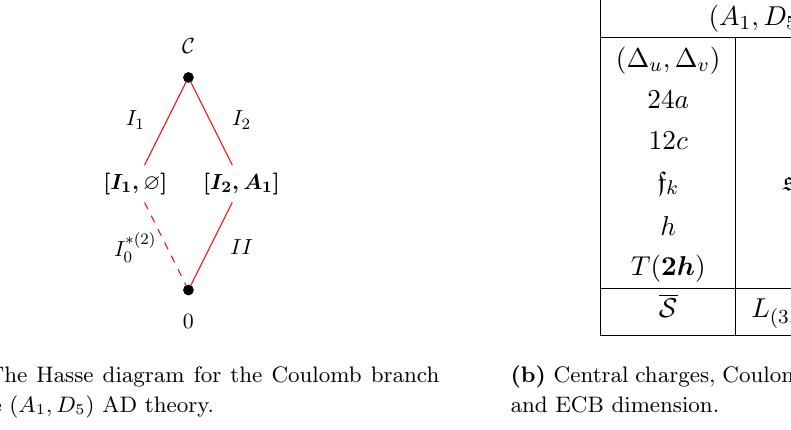
Figure 10. Information about the ( A 1 ; D 5 ) AD theory.